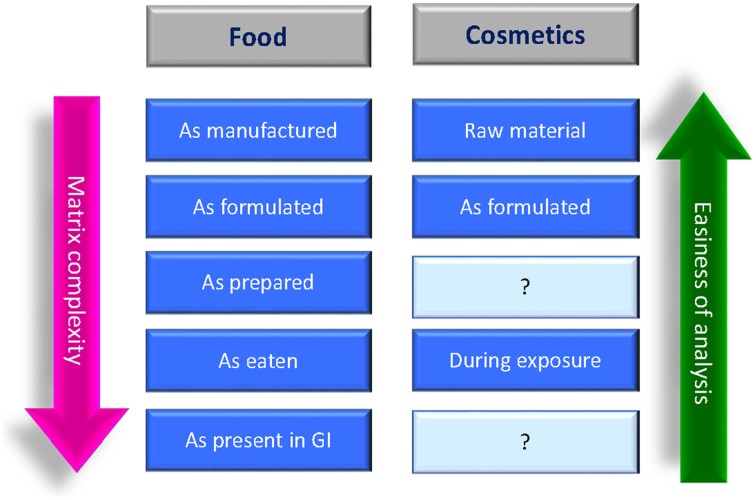
Suggested stages for the NPs characterization in food/feed products and in cosmetic/personal care products (SCCS, 2012a; Singh et al., 2014).